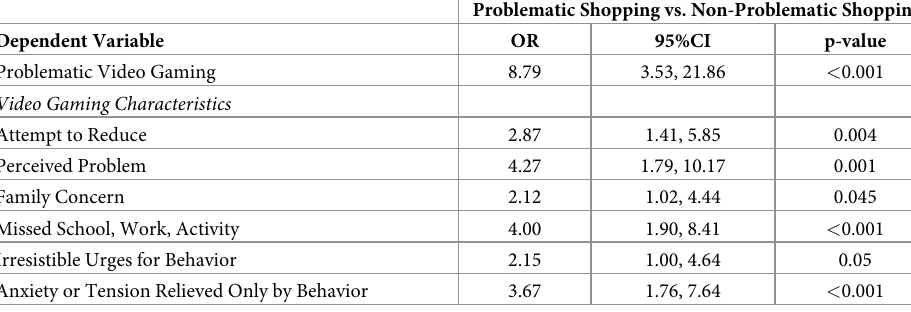
Table 4. Adjusted multivariate analysis of problematic video gaming in adolescents stratified by problematic- shopping